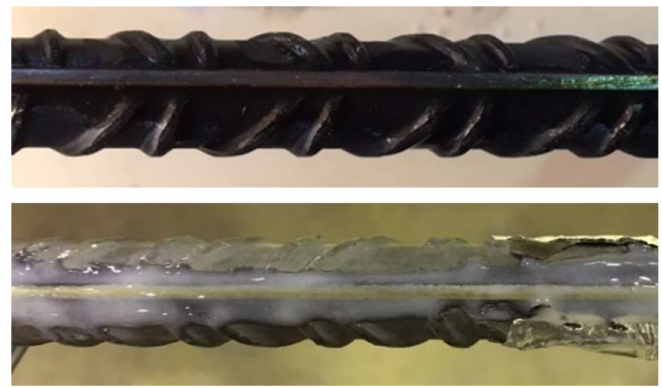
Figure 9. Adhesives on rebar of each beam specimen: cyanoacrylate (Beam 1— top ), two-component epoxy (Beam 2— bottom ).